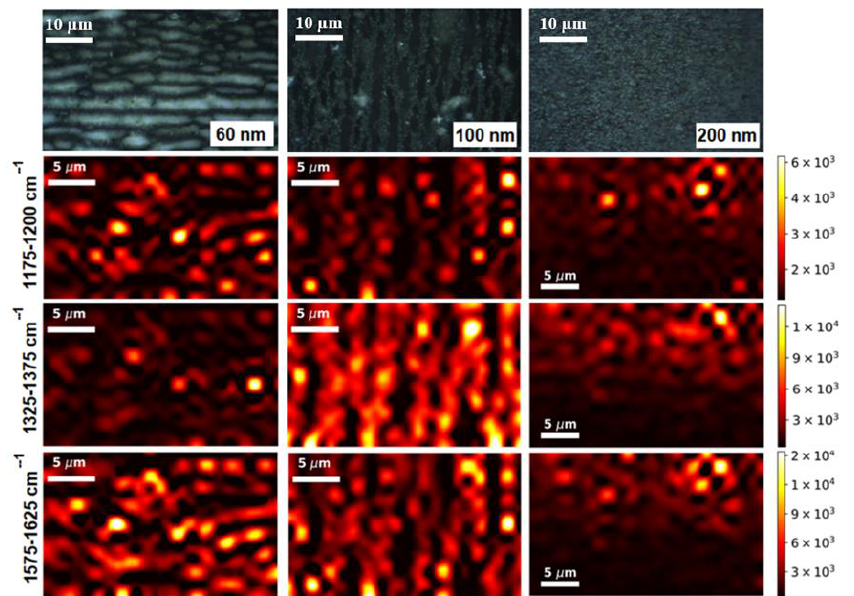
Figure 7. Optical microscopy images of SERS substrates with different NW diameters of 60, 100 and 200 nm (top line of images). SERS-mapping of H 2 Pc* (10 mM) adsorbed on substrates with NWs of 60, 100 and 200 nm in diameter, plotted in accordance with integral intensity (the area) under three characteristic Raman peaks (1175, 1350 and 1600 cm −1 ).